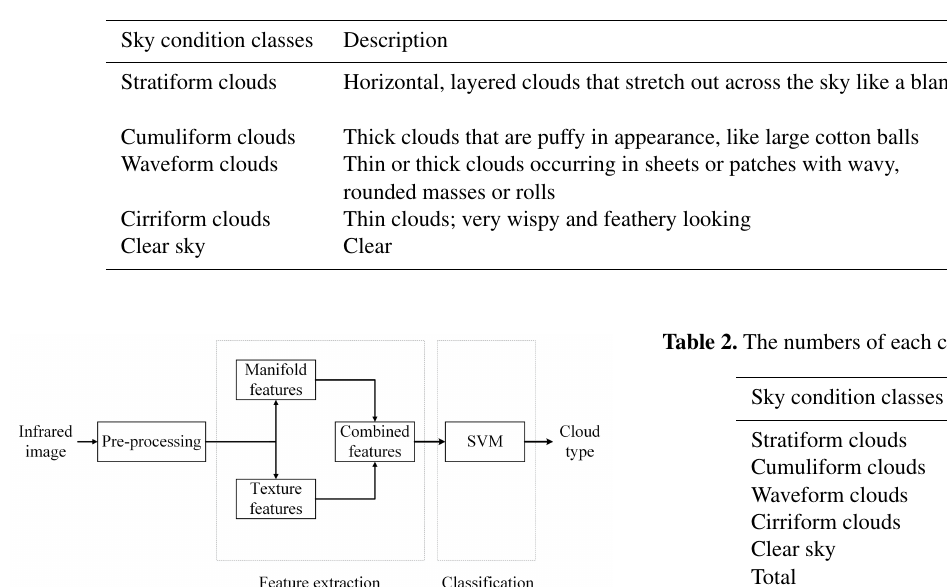
Table 1. The sky condition classes and corresponding description.